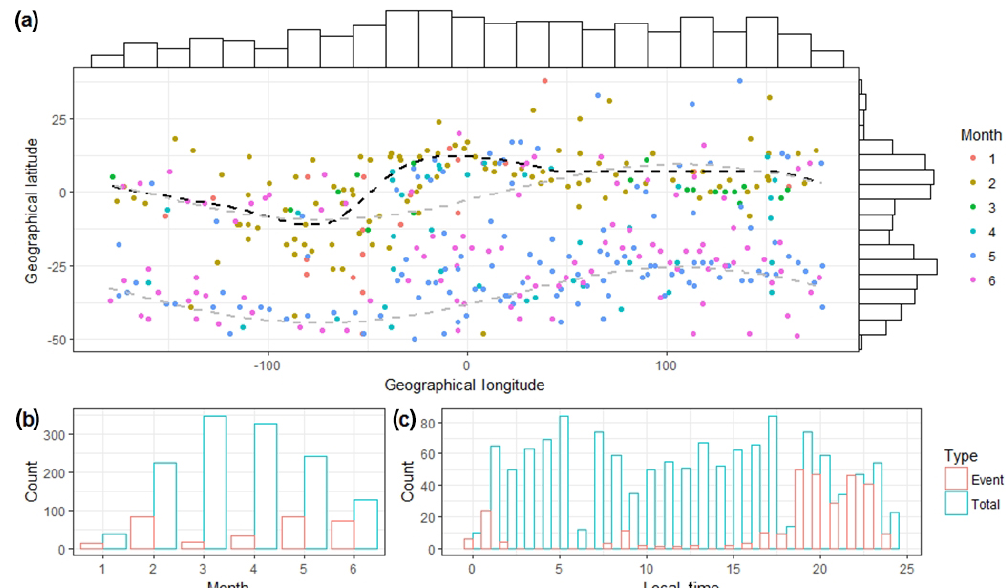
Figure 3. Distribution of detected stratification events and variations in occurrence number with local time and month. In (a) , each point represents a stratification event, and the location of each point indicates the position of the maximum data difference of that detected event. Color of each point indicates the occurrence month of the stratification event. Grey dashed line indicates the geomagnetic equator and 35 ◦ S geomagnetic latitude under dipole coordinates, and black dashed line indicates dip equator. In (b) and (c) , “Event” indicates detected stratification events, and “Total” indicates total co-located orbit